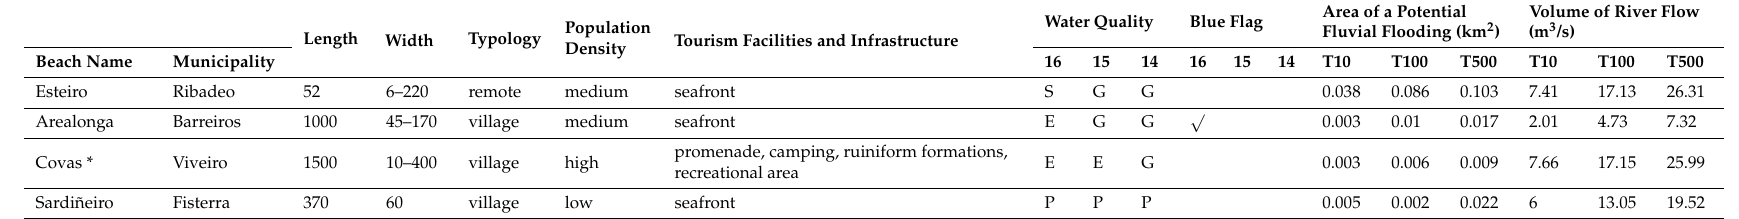
Table A2. Fluvial Flood